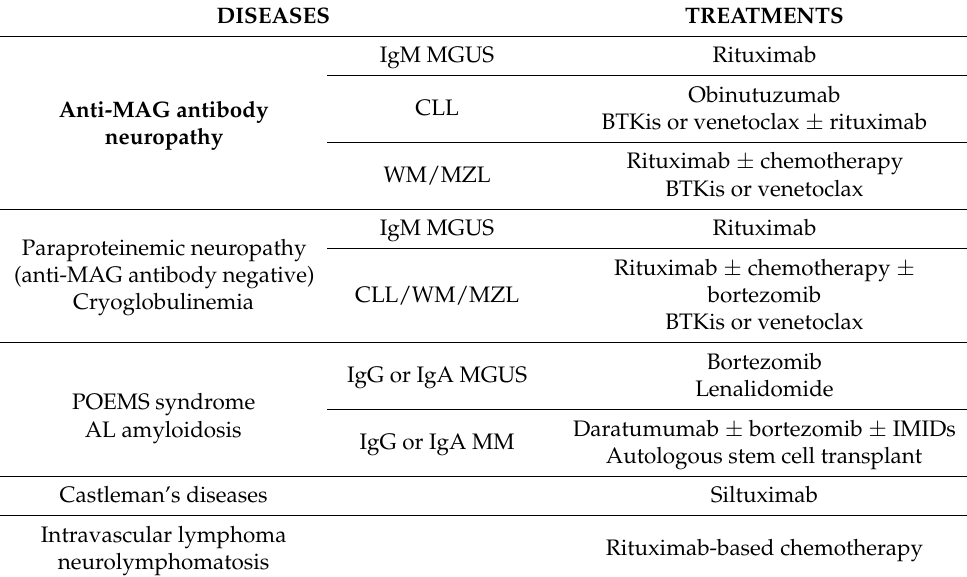
Table 1. Summary of diseases and